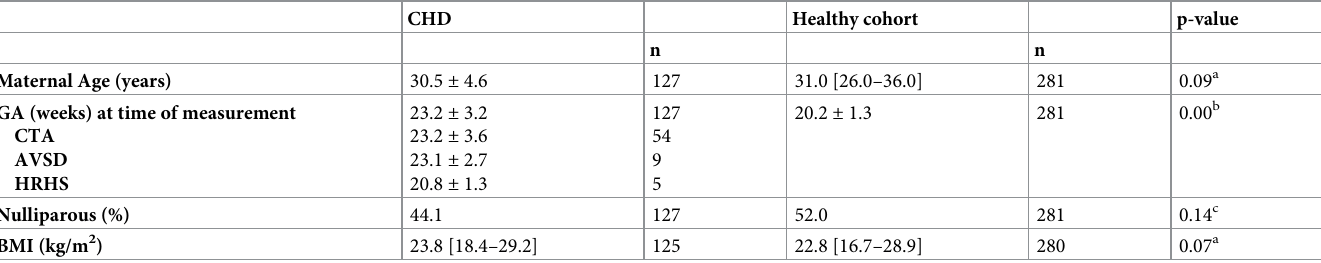
Table 2. Baseline characteristics of participants. CHD Healthy cohort